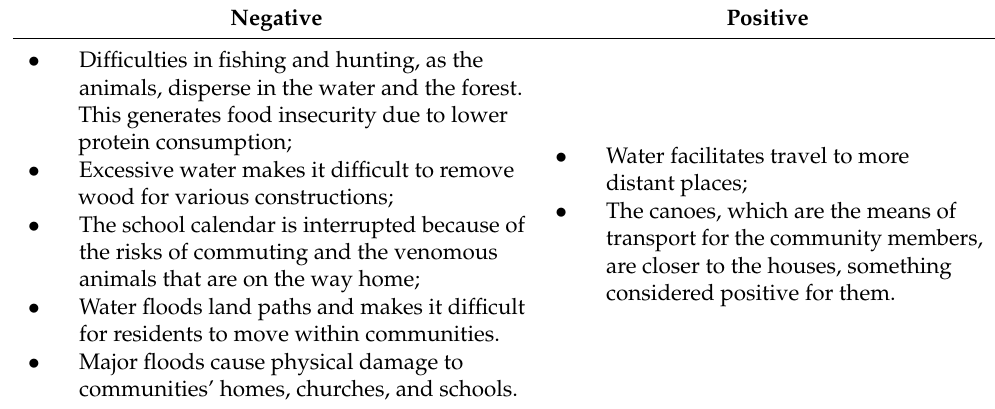
Table 1. Impacts of the great floods.